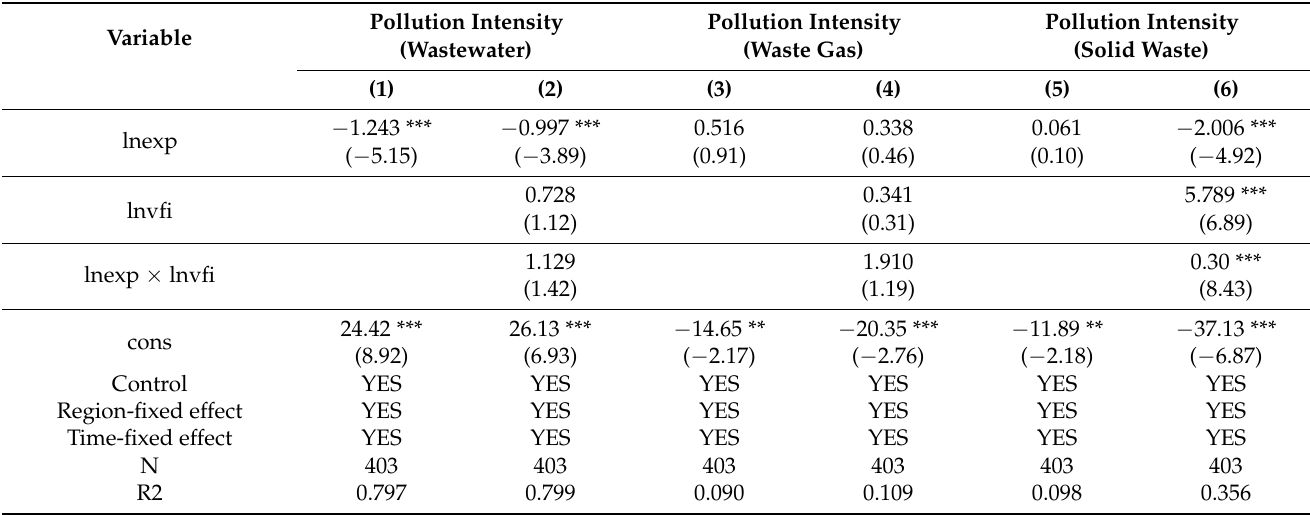
Table 7. Regression results of pollution reduction effect of fiscal expenditure structure (pollution